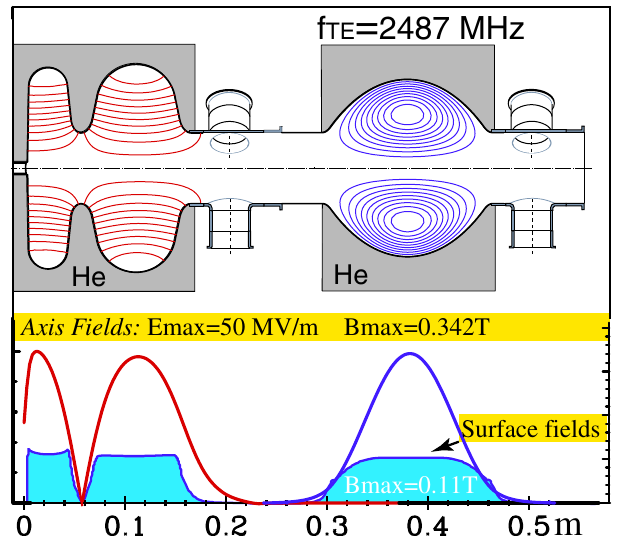
FIG. 4. (Color) Shape, field pattern, the axis, and surface fields cell superconducting cavity of the rf gun with the separated of 1 1 2 focusing cavity having TE mode frequency of 2487 MHz. 011